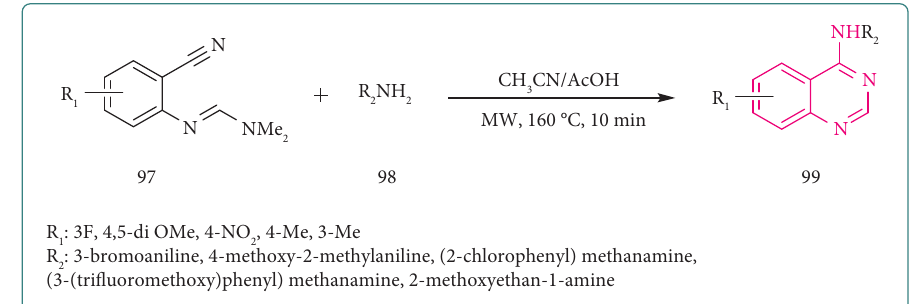
Scheme 17: Synthesis of 4-aminoquinazoline derivatives using N-(2-cyanophenyl)-N,N-dimethylformamidine under microwave irradi- ation conditions.